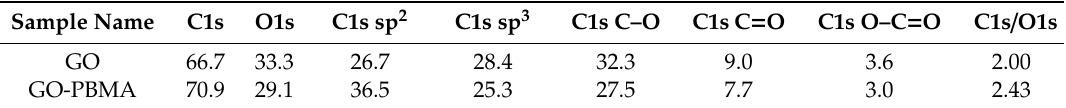
Table 1. The chemical composition on the surface of neat GO, GO-I and GO-PBMA. All values are in atomic